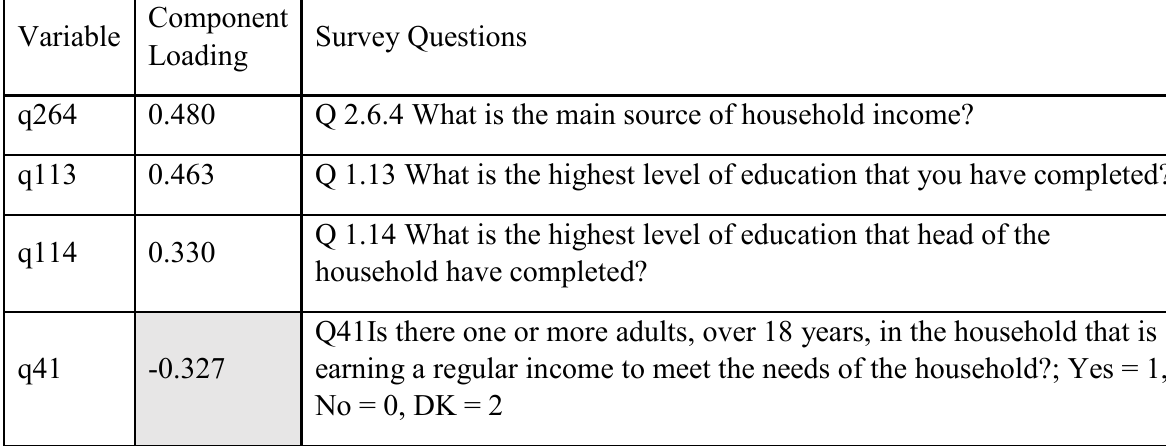
Table 1.36: Variables defining Adaptive Resilience PC7